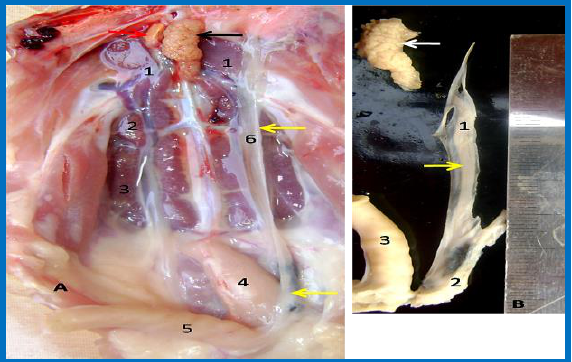
Figure, 3: Gross appearance at 12 weeks duck body shows: A. The cranial divisions of left & right kidneys (1), middle division of right kidney (2), caudal division of right kidney (3), supra cloaca gland (4), rectum (5), ventral oviductal ligament (6), left ovary (Black arrow), right ovary ( red arrow) and left oviduct (Yellow arrow). B. The ovary (White arrow) and the left oviduct (yellow arrow) which consisted of cranial end (1), caudal end (2). Rectum